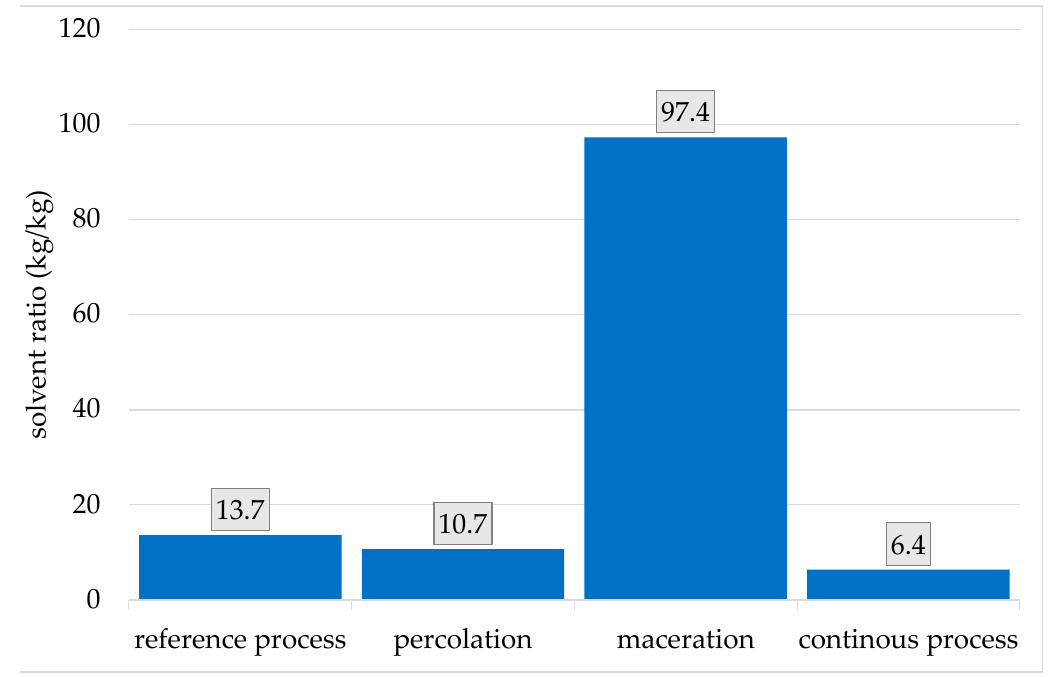
Figure 10. Solvent saving potential of a typical industrial process for extract production.